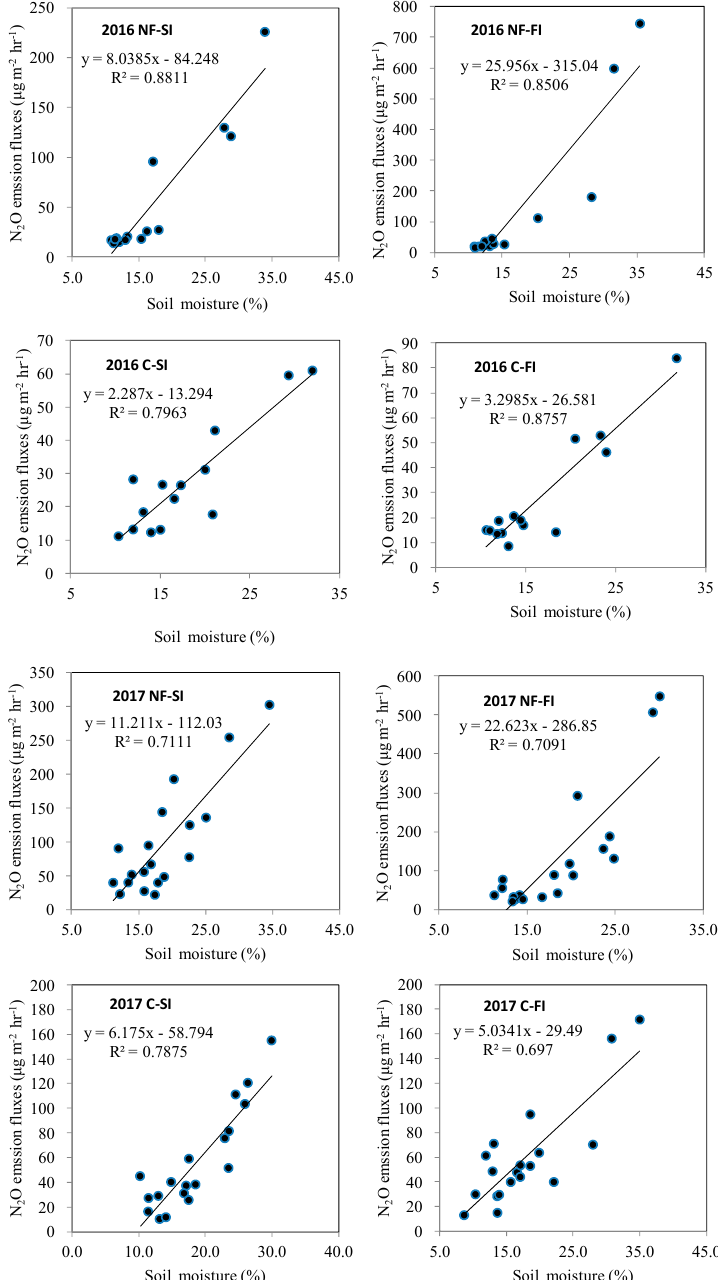
Figure 3. Correlation analysis between soil moisture and N 2 O emission flux under NF-SI, NF-FI, C-SI, and C-FI conditions in 2016 and 2017.